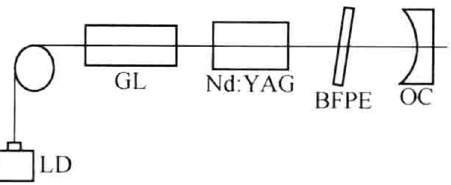
Figure 7. Experimental setup of diode-pumped birefringent dual-frequency Nd : YAG laser [23] . LD: laser diode; GL: gradient-index lens; BFFP: birefringent Fabry–Perot etalon; OC: output coupler.